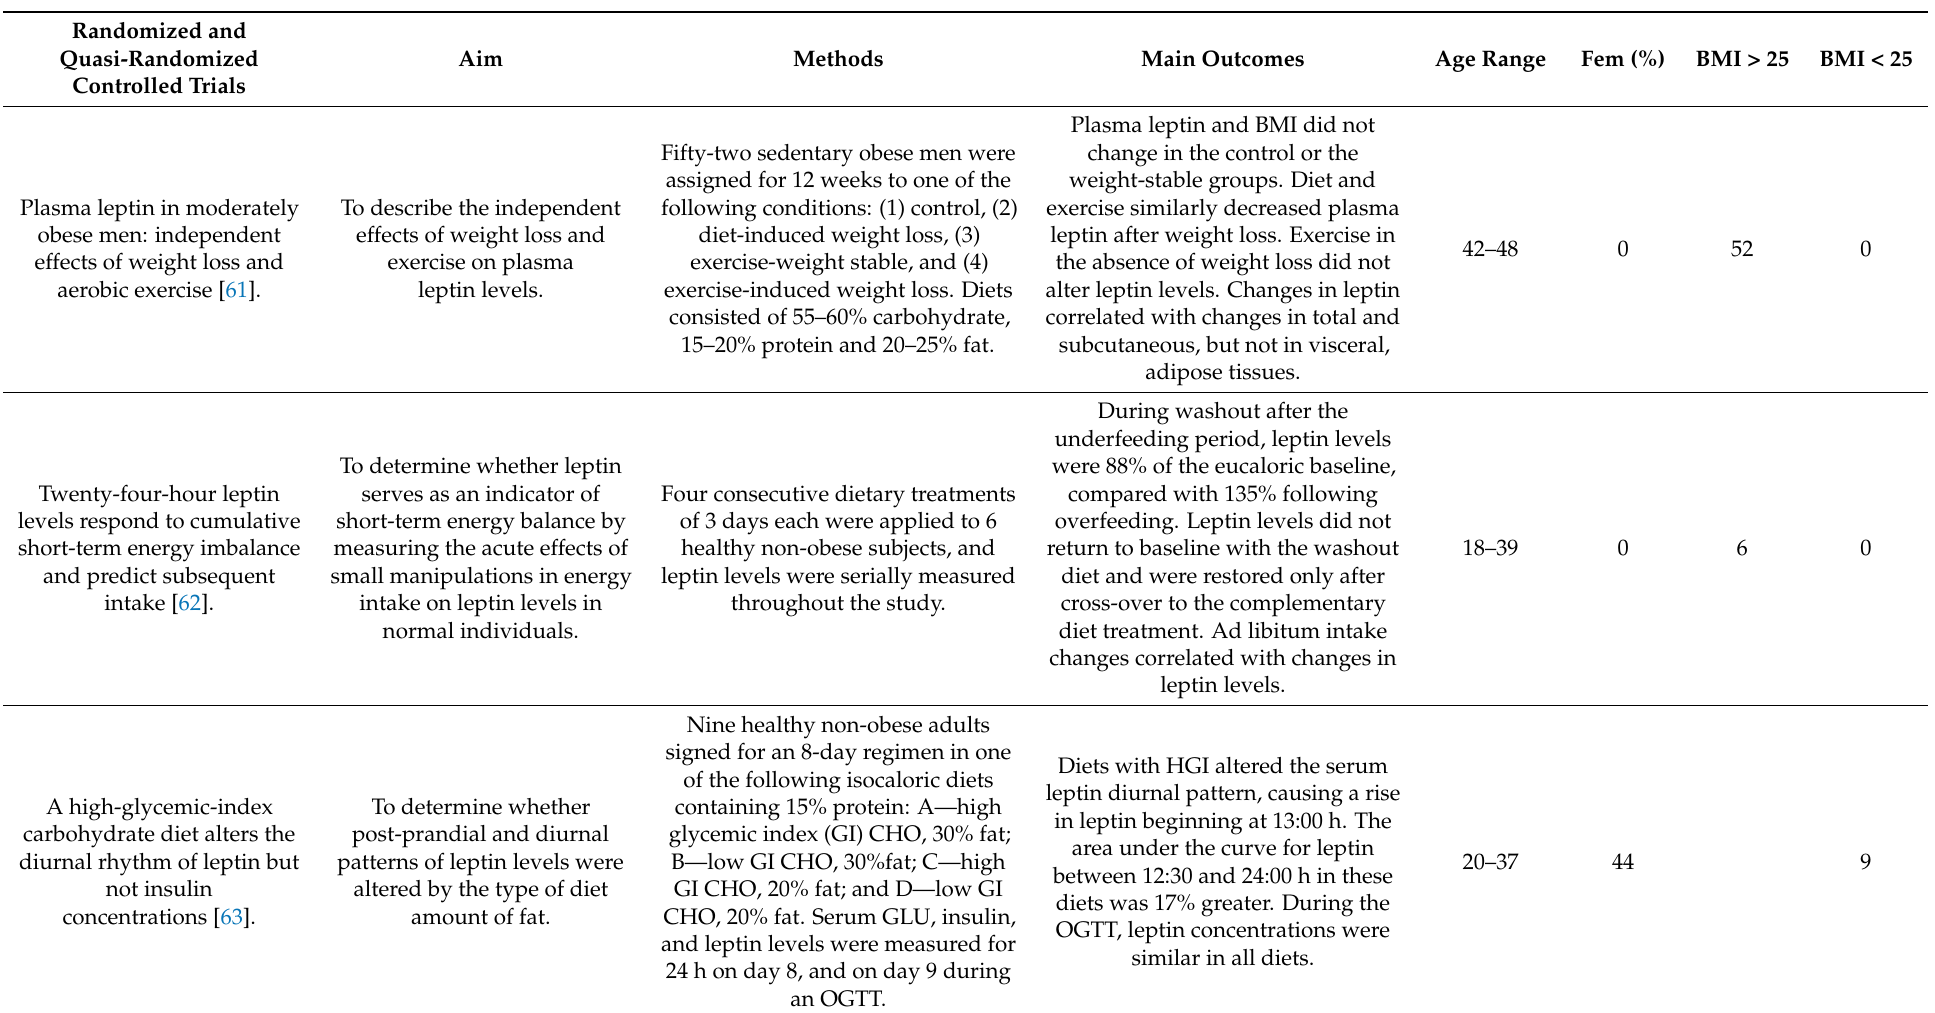
Table 2. Summary of non-controlled studies’